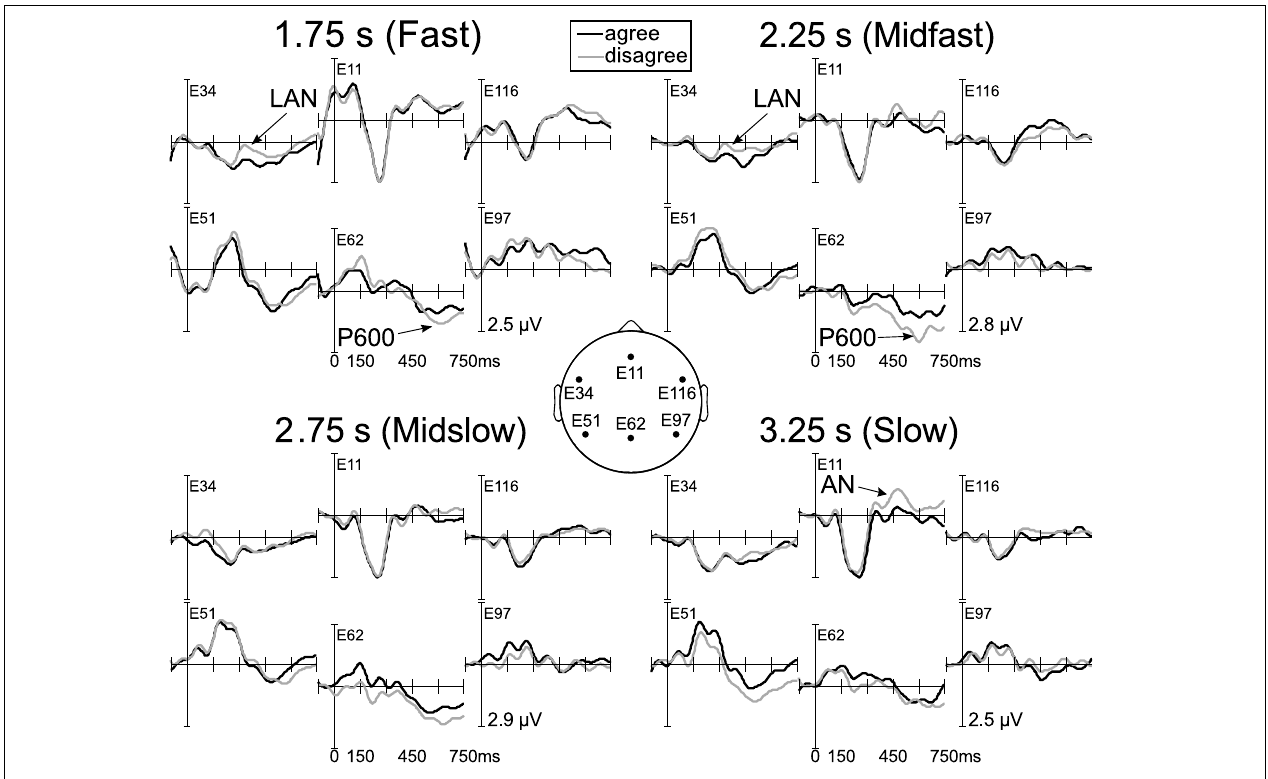
FIGURE 2 | ERPs from six channels at the four different rates of word presentation for sentence-final adjectives that agree (black line) or disagree (gray line) with the sentence-initial pronoun as regards number. Between 300 and 450ms, there was a left-lateralized negativity at